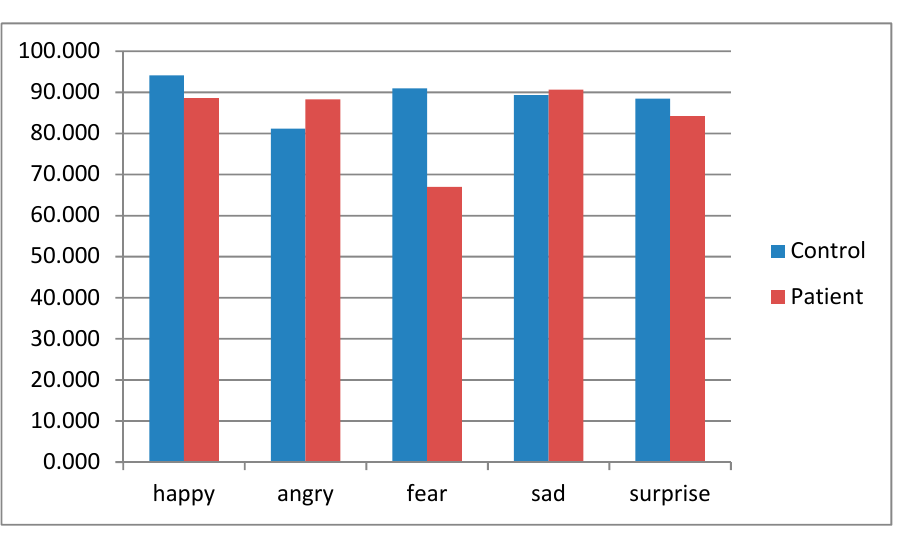
Figure 4. Percentage of correct answers in emotion recognition among patients with schizophrenia and the control group.